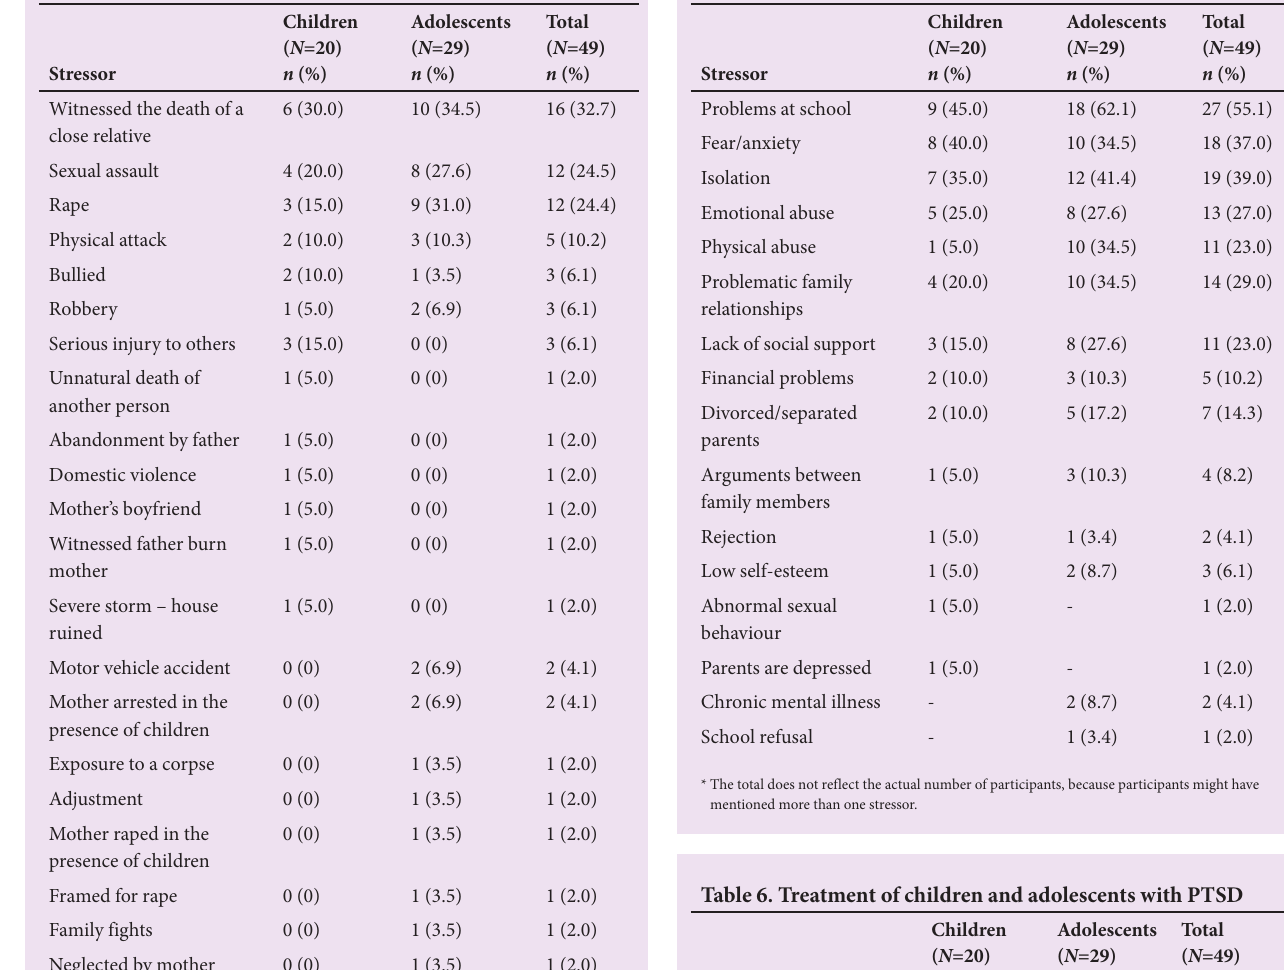
Table 5. Associated stressors identified in children and adolescents with PTSD*